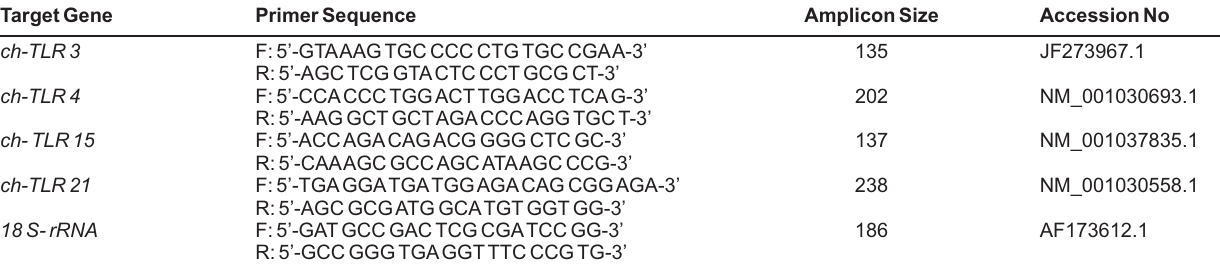
Table-1. List of primers used in the study Target Gene